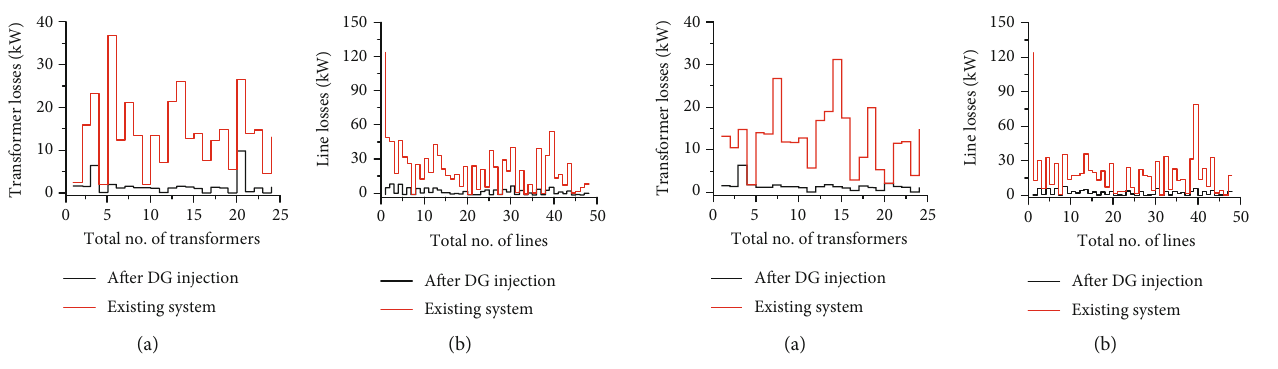
Figure 19: (a) Transformer losses and (b) line losses before and after DG in zone B.